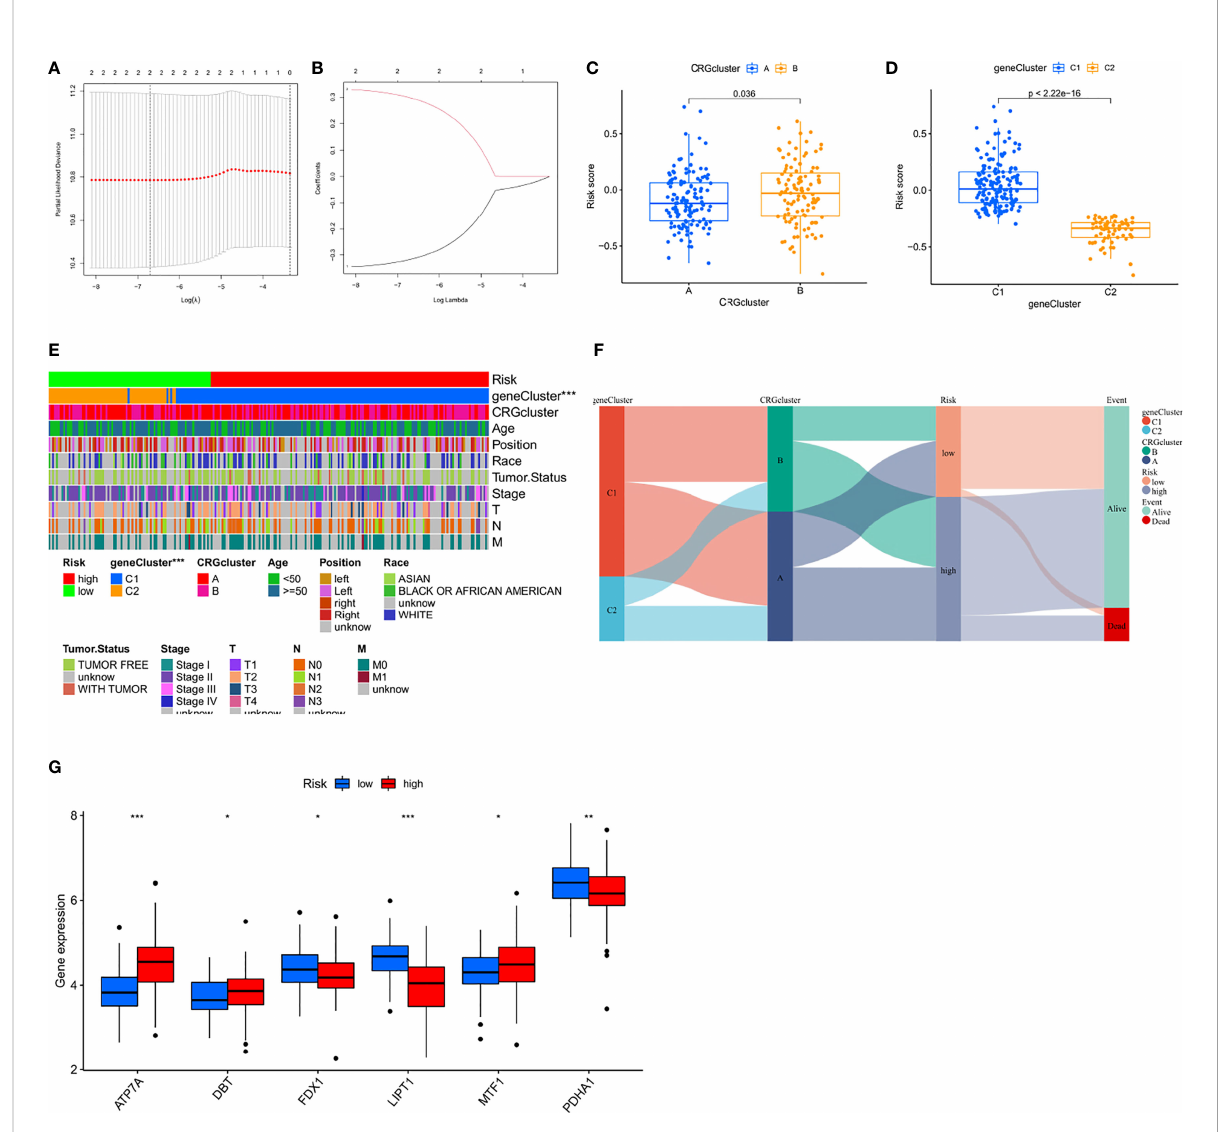
FIGURE 5 Construction of the prognosis risk prediction model (A, B) The least absolute shrinkage and selection operator (LASSO) regression was performed with the minimum criteria. (C, D) Differences in CRG_score between gene subtypes and cuprotosis subtypes (E) Differences in clinicopathologic features and expression levels of CRGs between the high-and low-risk group. (F) Alluvial diagram of subtype distributions in groups with different CRG_scores and survival outcomes. (G) Six differential expressions of CRGs in high and low risk groups. The asterisks represented the statistical p value (*P < 0.05; **P < 0.01; ***P <